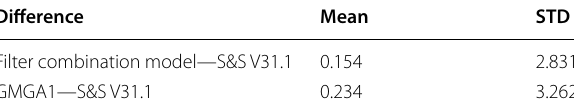
Table 13 Statistics on the accuracy of the new results